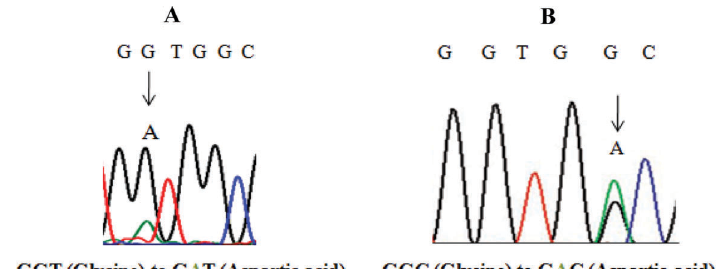
Figure 3. Examples of sequence analysis of K ras . A , G to A transition in codon 12 in tumor sample (glycine to aspartic acid). B , G to A transition in codon 13 in tumor sample (glycine to aspartic